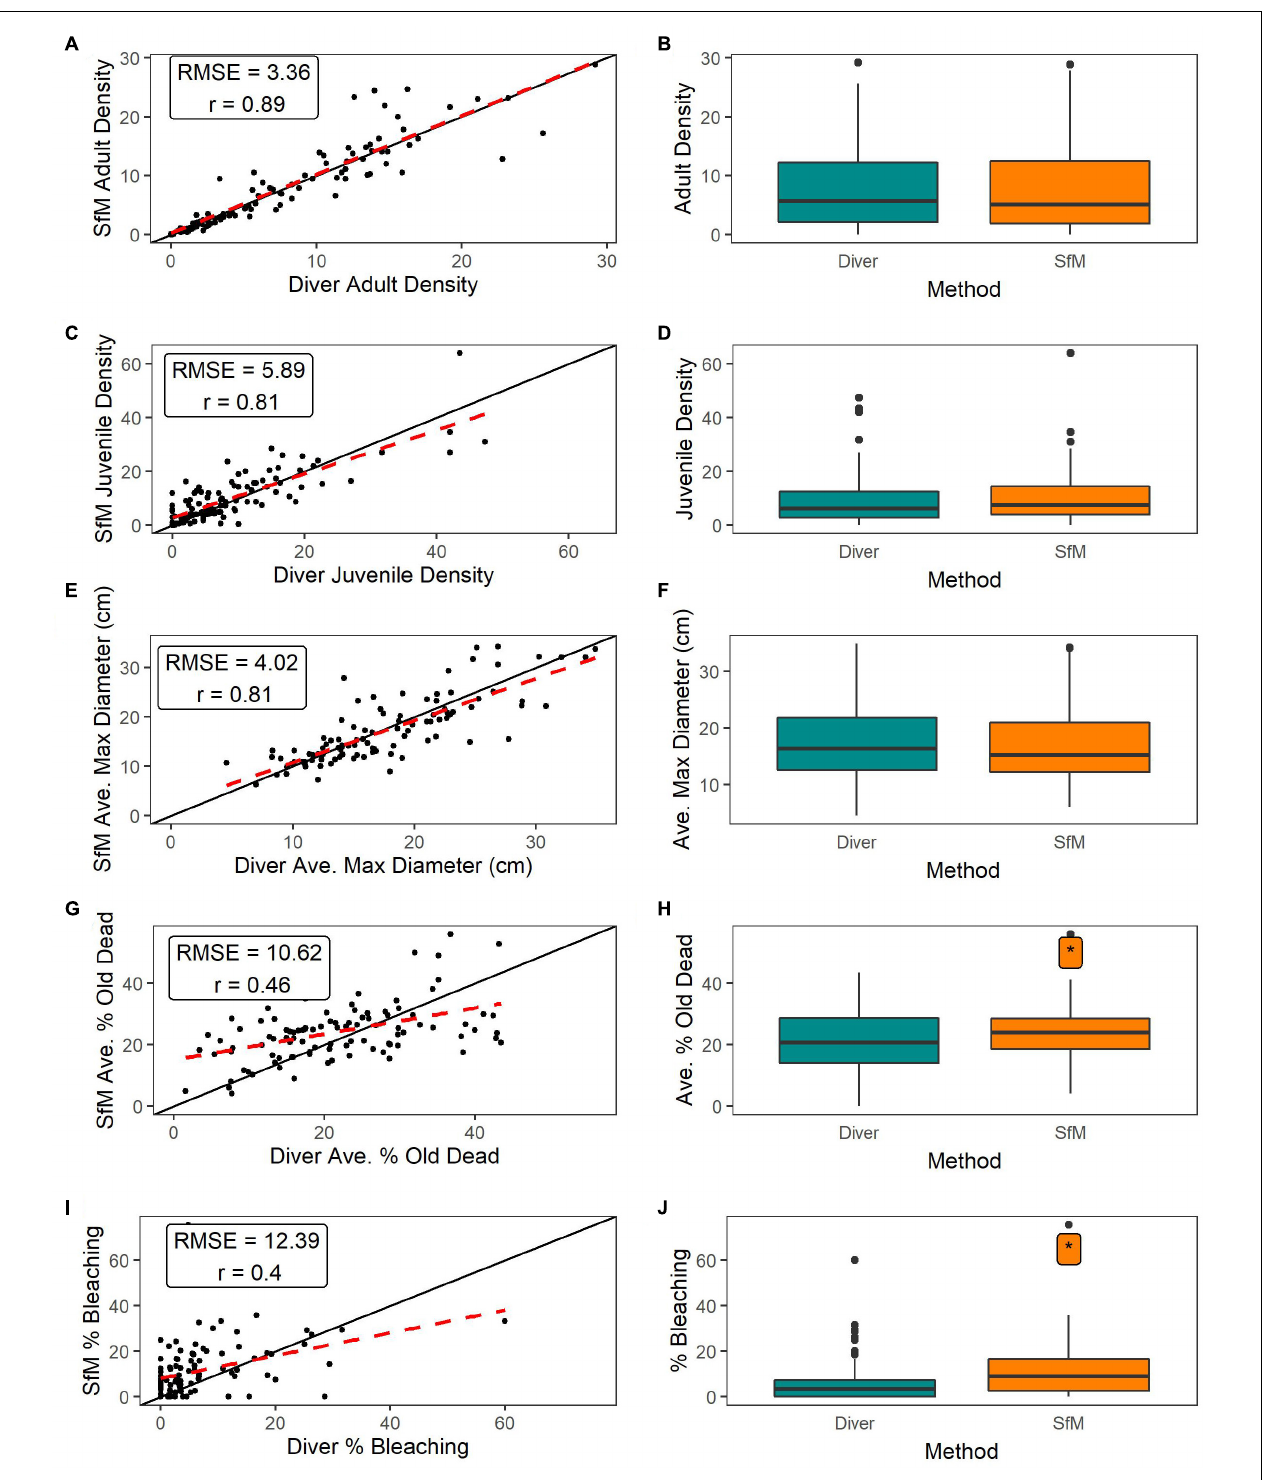
FIGURE 5 | (A,C,E,G,I) 1:1 Plots of the paired site-level SfM versus diver data for adult colony density, juvenile colony density, average adult maximum diameter, average adult colony percent old partial mortality, and bleaching prevalence, respectively (points). Black line is 1:1 line, red dashed line is linear regression line for all 1:1 plots. (B,D,F,H,J) Boxplots of site-level data by method type for adult colony density, juvenile colony density, average adult maximum diameter, average adult colony percent old partial mortality, and bleaching prevalence, respectively. Asterisk, when present, indicates significant difference between methods based on LMMs and LRTs (B,D,F,H) and nonparametric Wilcoxon Test (J) ( α = 0.05).